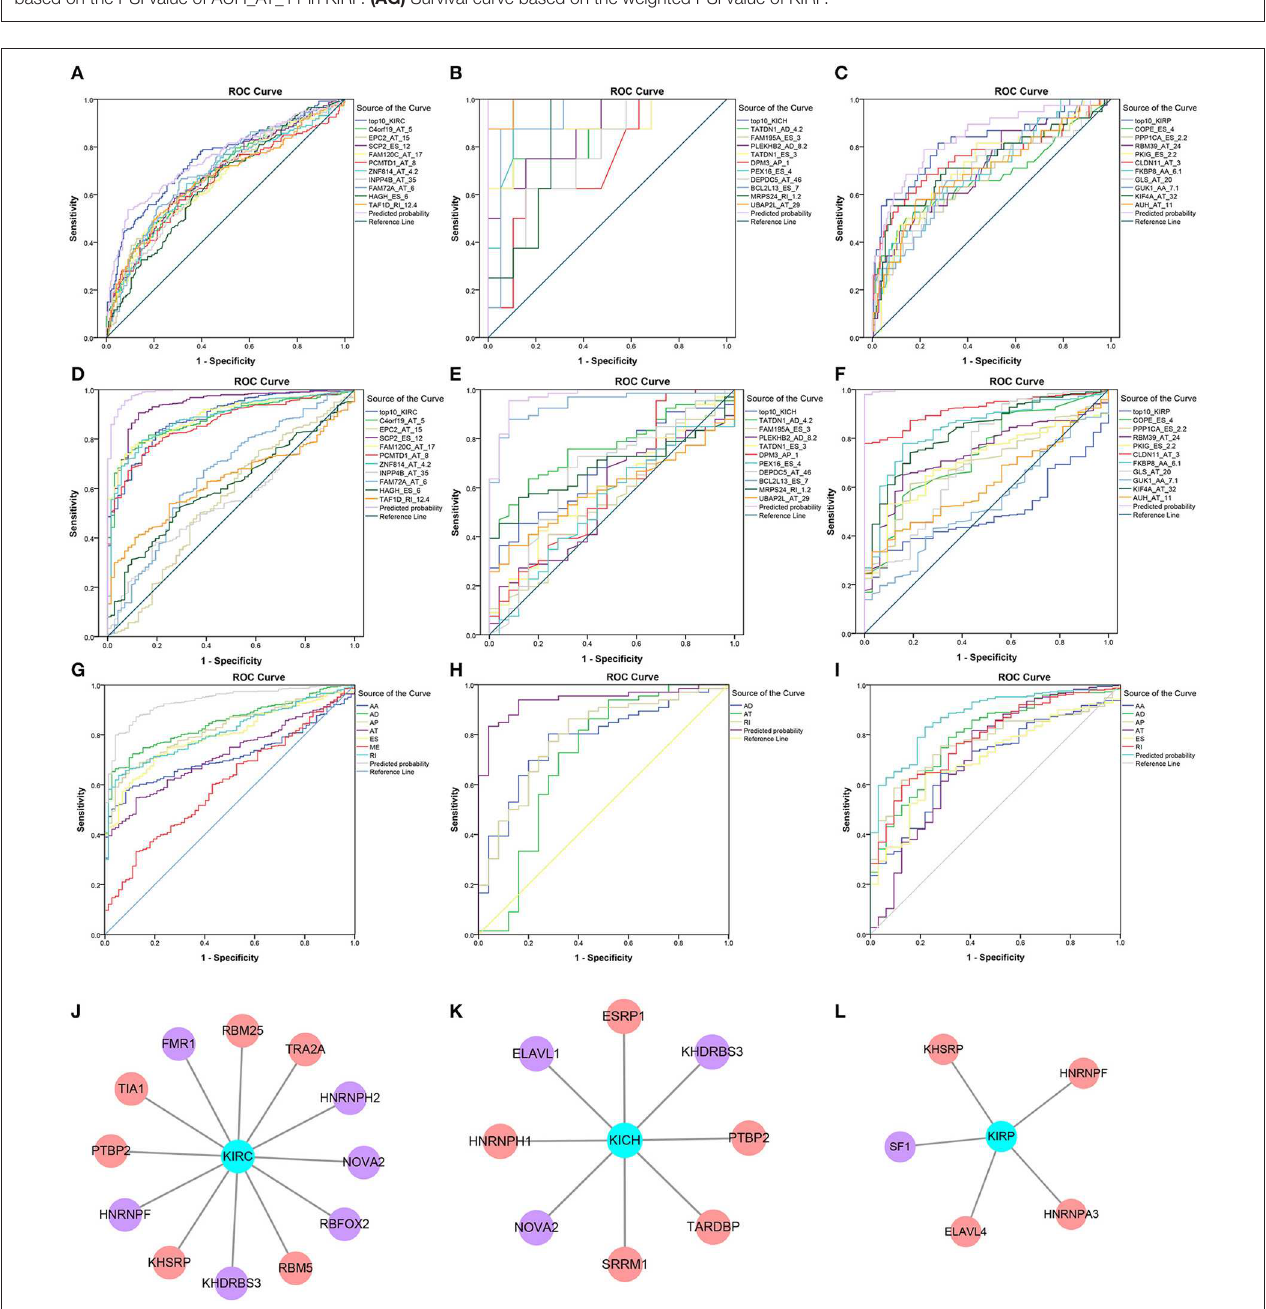
FIGURE 4 | KICH. (W) Survival curve based on the PSI value of COPE_ES_4 in KIRP. (X) Survival curve based on the PSI value of PPP1CA_ES_2.2 in KIRP. (Y) Survival curve based on the PSI value of RBM39_AT_24 in KIRP. (Z) Survival curve based on the PSI value of PKIG_ES_2.2 in KIRP. (AA) Survival curve based on the PSI value of CLDN11_AT_3 in KIRP. (AB) Survival curve based on the PSI value of FKBP8_AA_6.1 in KIRP. (AC) Survival curve based on the PSI value of GLS_AT_20 in KIRP. (AD) Survival curve based on the PSI value of GUK1_AA_7.1 in KIRP. (AE) Survival curve based on the PSI value of KIF4A_AT_32 in KIRP. (AF) Survival curve based on the PSI value of AUH_AT_11 in KIRP. (AG) Survival curve based on the weighted PSI value of KIRP.